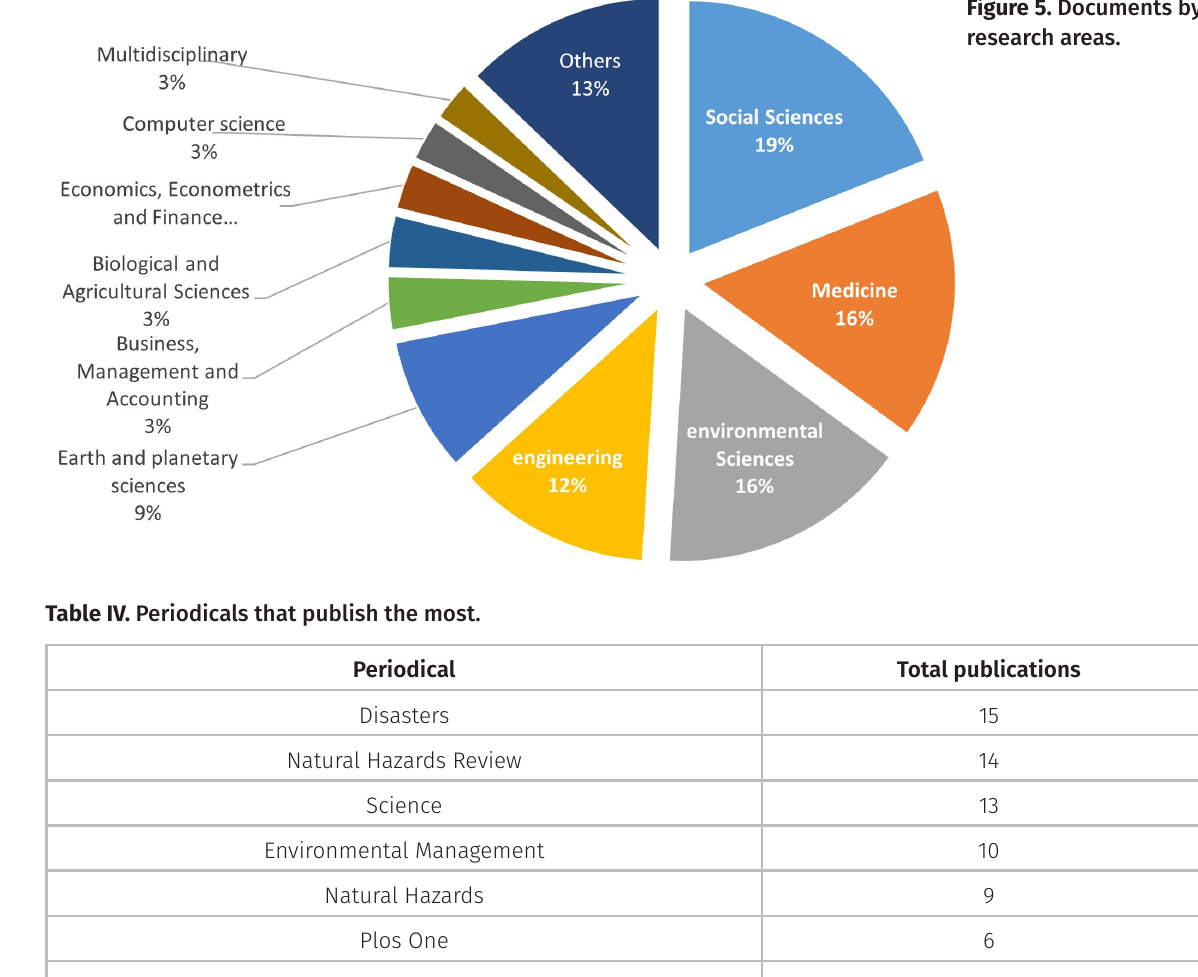
Figure 5. Documents by research areas.